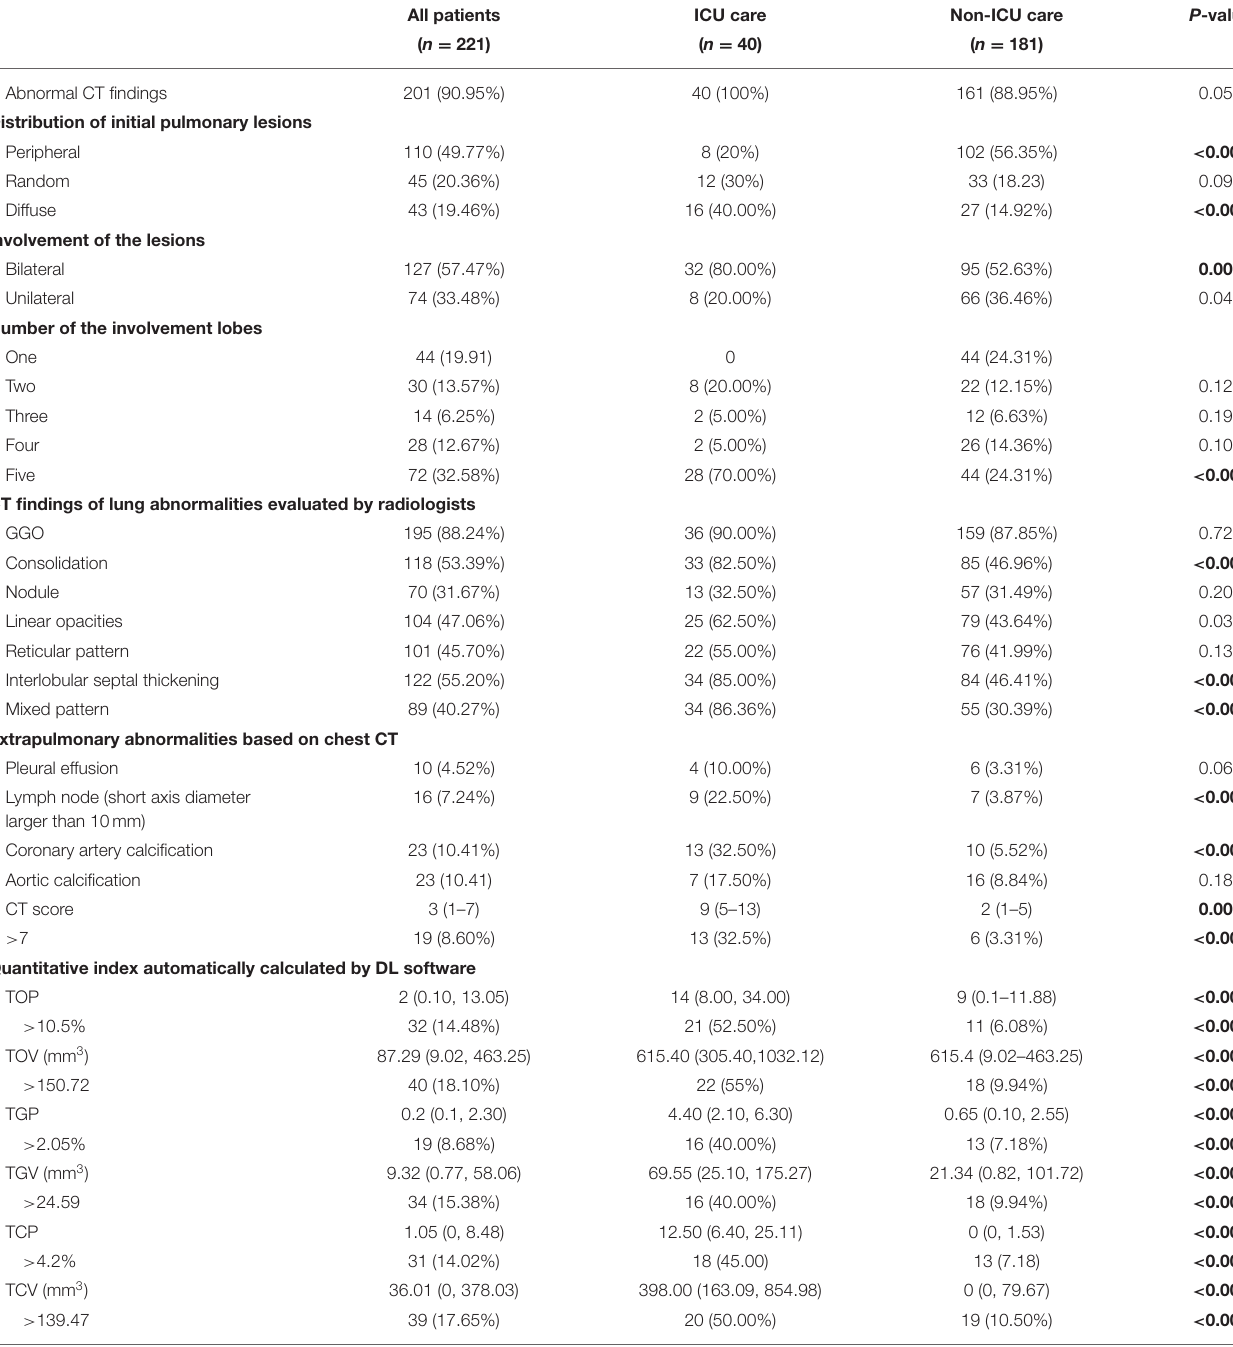
TABLE 3 | CT findings between ICU group and non-ICU group.